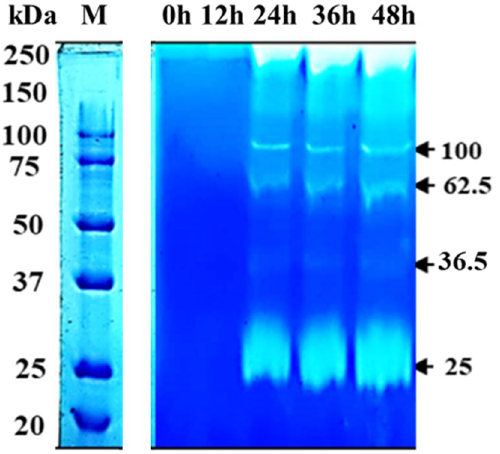
Figure 7. Keratinase zymogram showing NCIM 5802 keratinase during the course of fermentation at different time intervals (0 h-48 h), M: standard protein marker. The semi-native PAGE contained 1% feather keratin. The gel was stained with Coomassie Blue after 24 h of incubation at 40 °C.